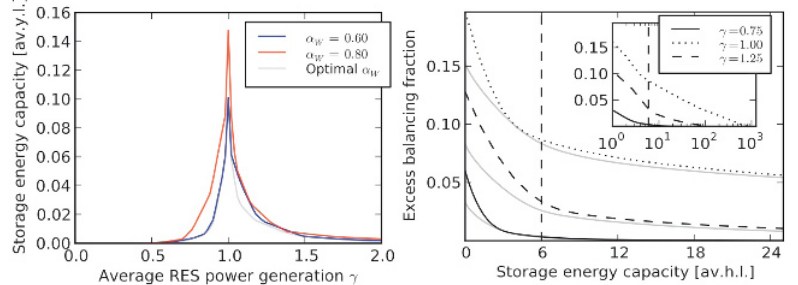
Fig. 3. Left panel: Minimum sufficient storage energy capacity vs. average RES power generation ( ! ) for different fractions of wind power ( "